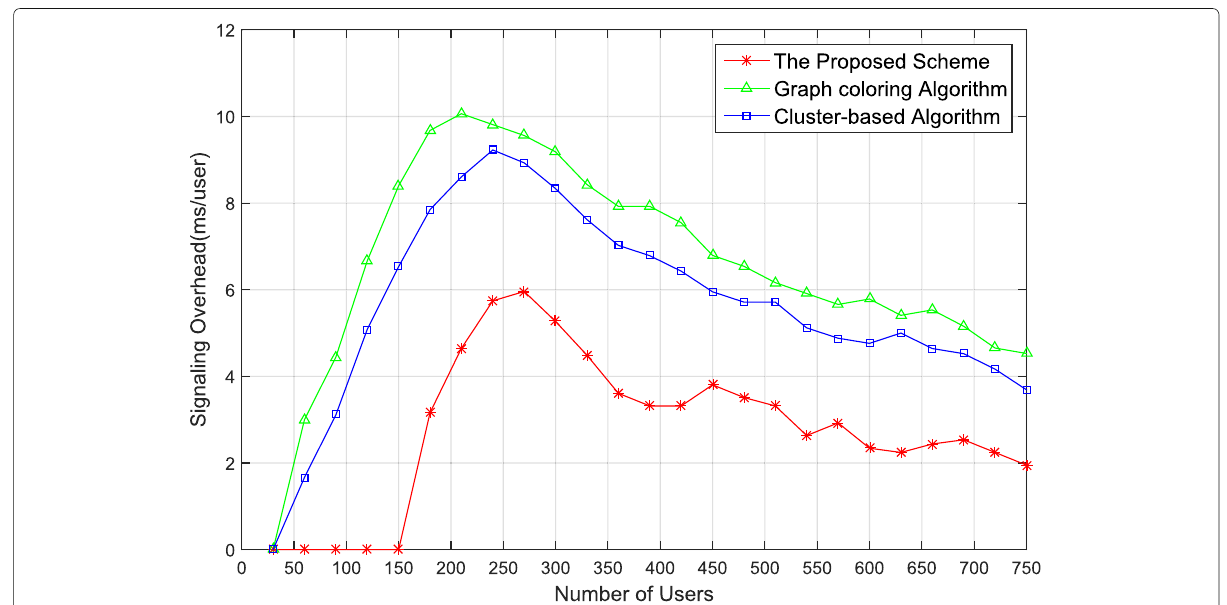
Fig. 10 Comparison of signaling overheads. Users include those with access and those denied